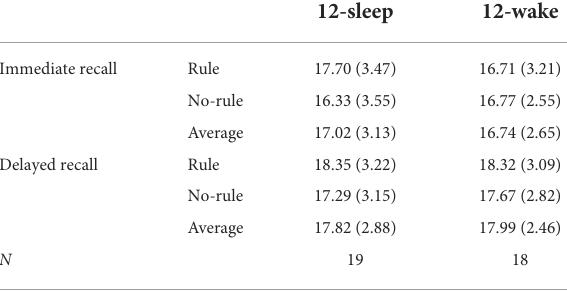
TABLE 2 Temporal order memory at immediate and delayed testing in experiment